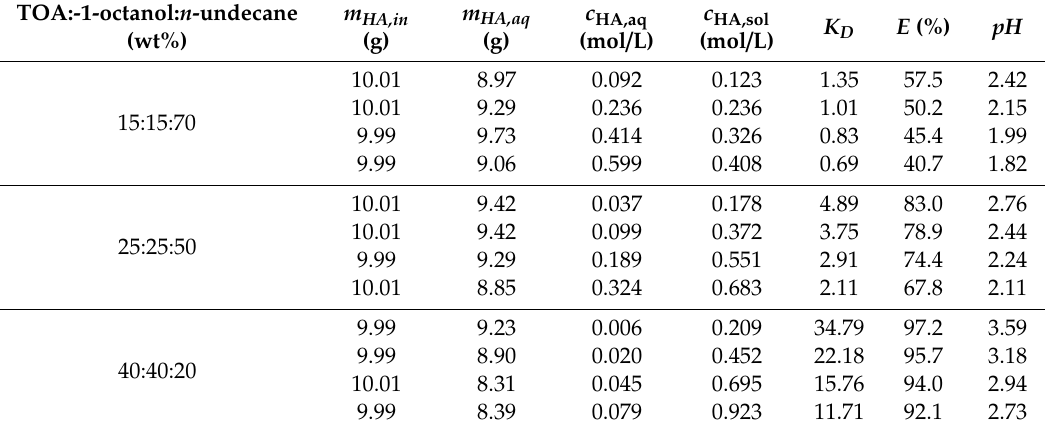
Table 2. Summary of the distribution coe ffi cient, the extraction e ffi ciency and the pH value in equilibrium for lactic acid with di ff erent solvent compositions; c acid,initial = 0.2–1 mol / L; T = 25 ◦ C; ambient pressure; solvent:water =